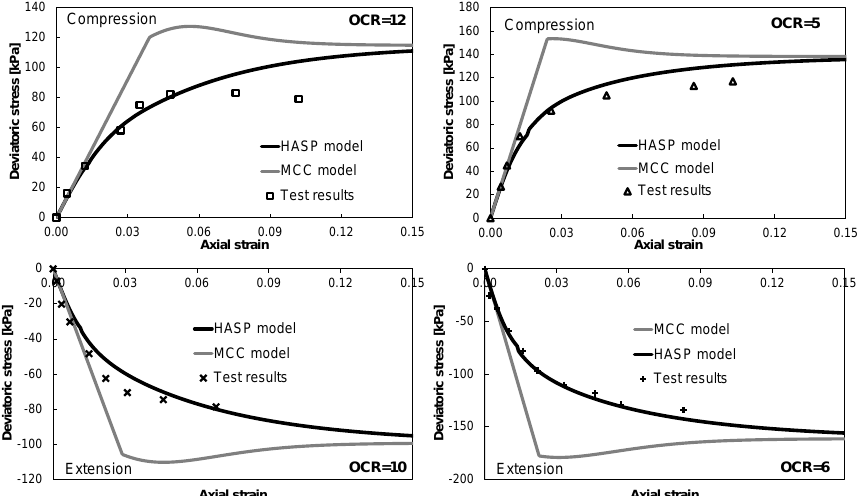
Figure 2. CU triaxial test, Cardiff clay — deviatoric stress-axial strain relations [27]. OCR — overcon- solidation ratio.